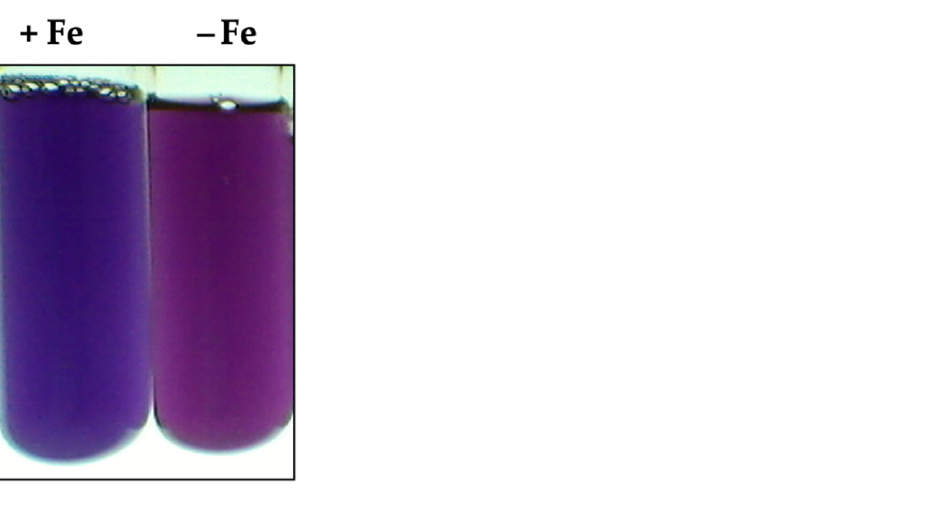
Figure 7. Production of siderophores by G. diazotrophicus PAL5 strains in response to iron availability. 2.5. fur Insertional Mutants and Complementation of an E. coli fur Mutant by G. diazotrophicus